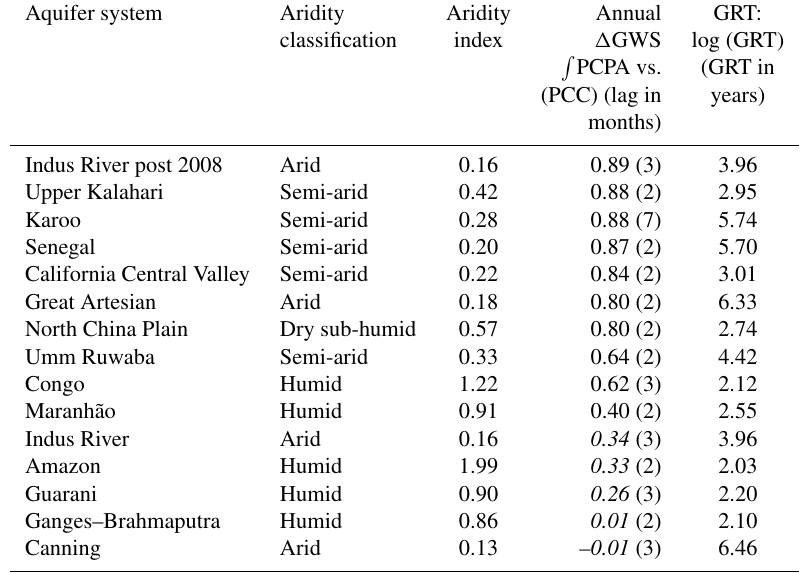
Table 4. Relationship between aridity index, climate and regional-scale hydrogeology: data linking climate and regional-scale hydrogeology to GW dynamics. Italicised results fall below t -test threshold.